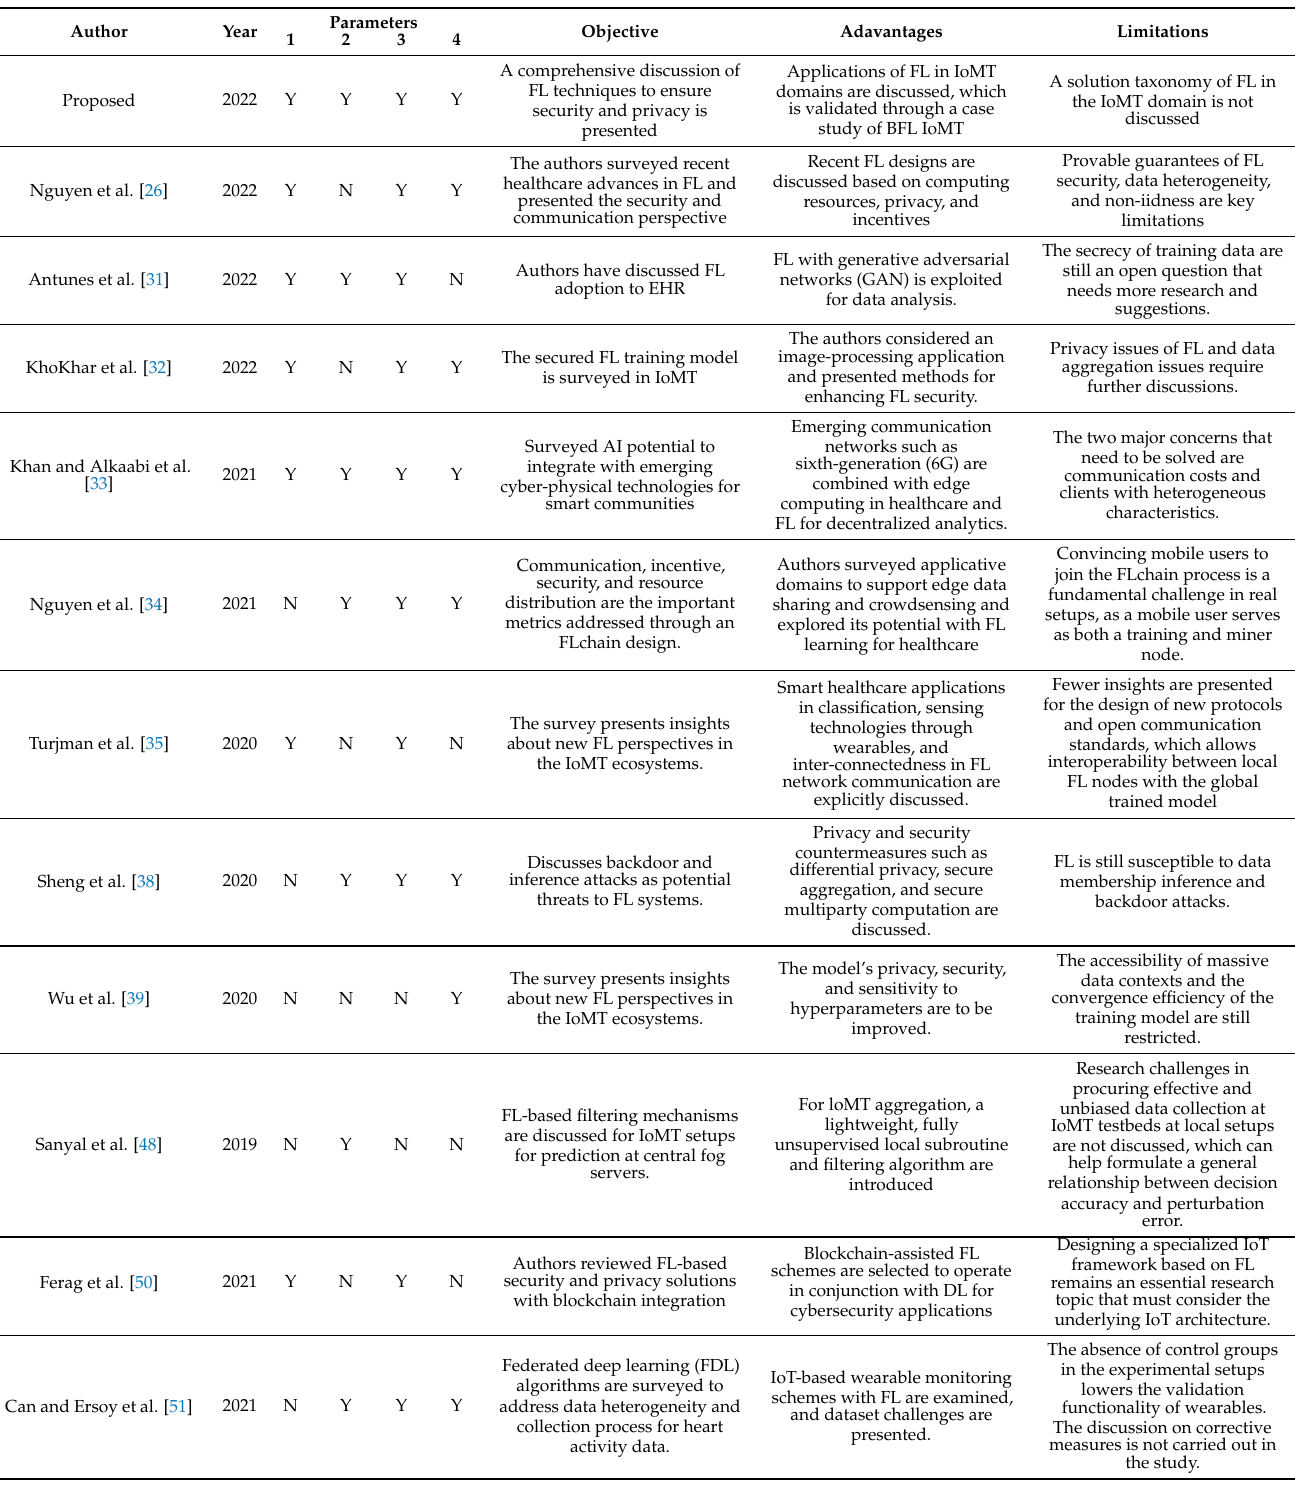
Table 3. Comparative analysis of the proposed survey with existing state-of-the-art